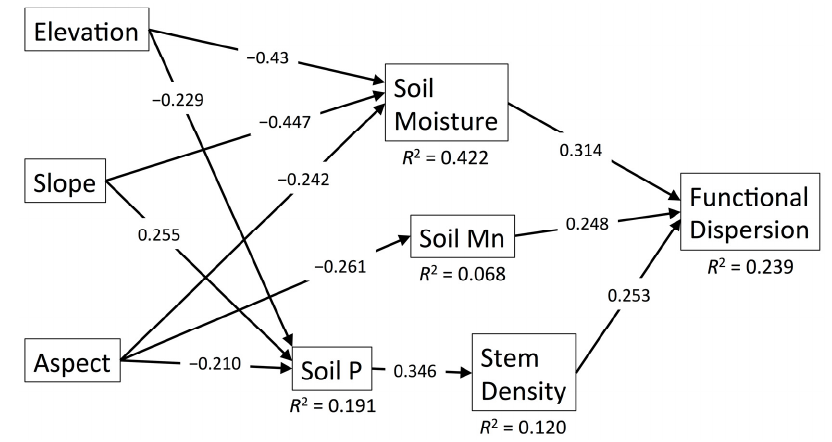
Figure 2. Path diagram for functional dispersion (F Dis ). Standardized path coefficients are given. R 2 values are total explained variance. R 2 values are total explained